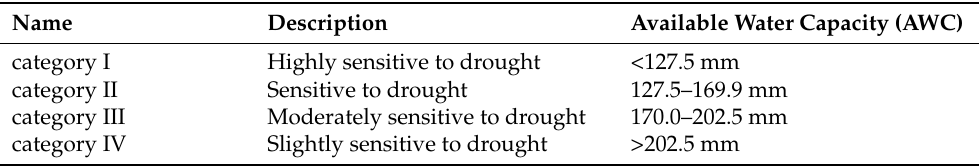
Table 1. Description of soil drought vulnerability